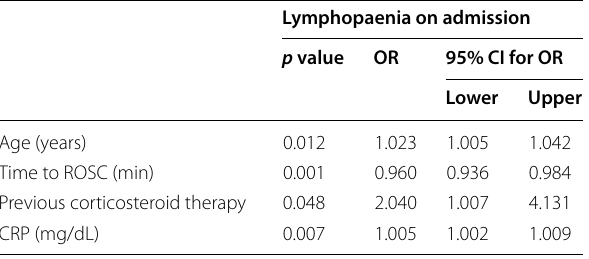
Table 3 Multivariable regression analysis to identify inde- pendent predictors of lymphopaenia on admission